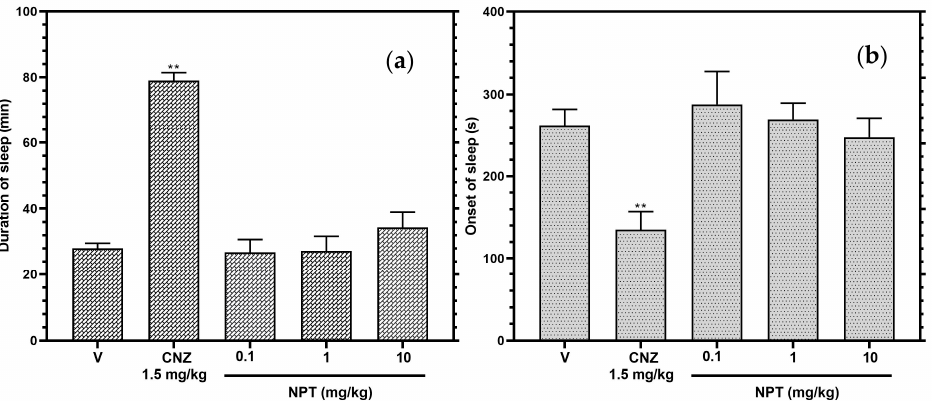
Figure 7 . Sedative e ff ects of NPT. The action of NPT (0.1, 1 and 10 mg/kg p.o.) was determined by the beginning of sleep ( a ) and length of sleep ( b ) in the pentobarbital-generated sleeping test. Clonazepam (CNZ) was the anxiolytic drug at 1.5 mg/kg p.o. The results of all experimental groups are reported as the mean values (±SEM). n = 8, ** p < 0.05 regarding to the vehicle group (indicated as V).